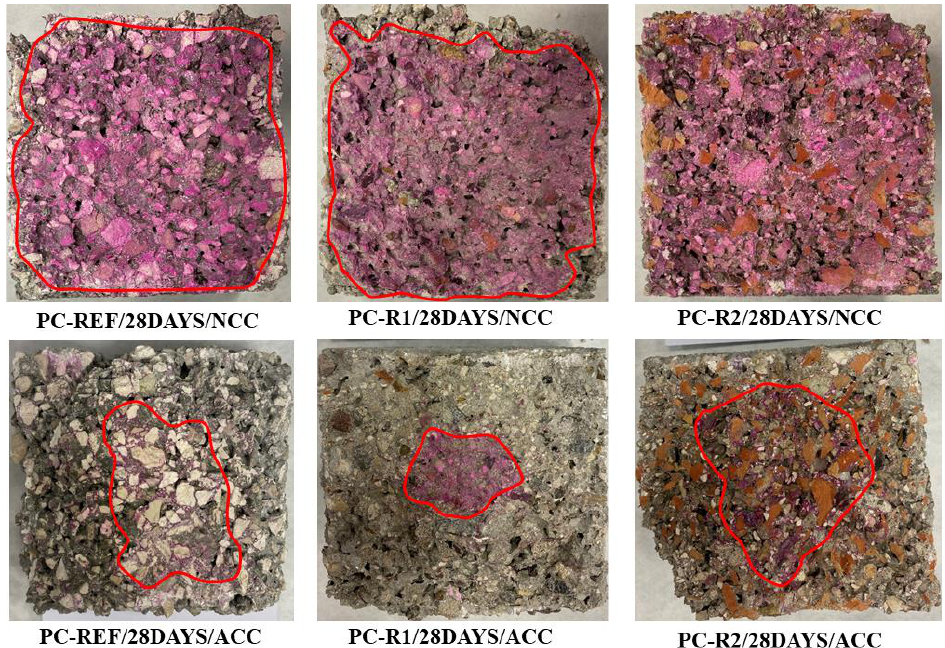
Figure 7. Carbonation depth of the different mixtures at 28 days of curing in NCC and ACC envi- ronment.